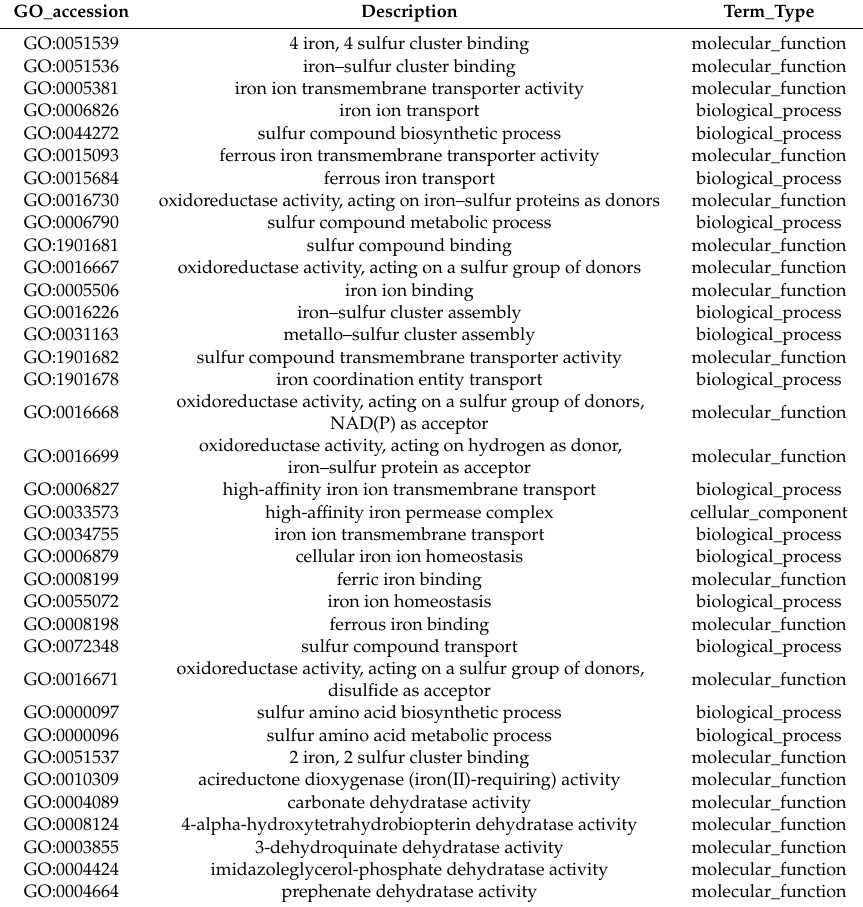
Table A1. Significantly GO term involved in Fe–S cluster stabilization and biogenesis under high-copper